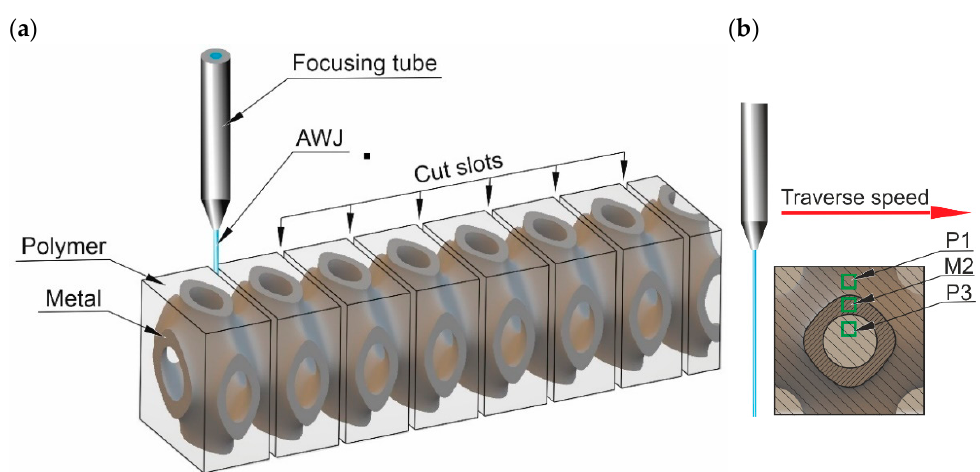
Figure 4. Details of the AWJ cutting tests: ( a ) the cut slot locations, ( b ) the roughness measuring area locations.